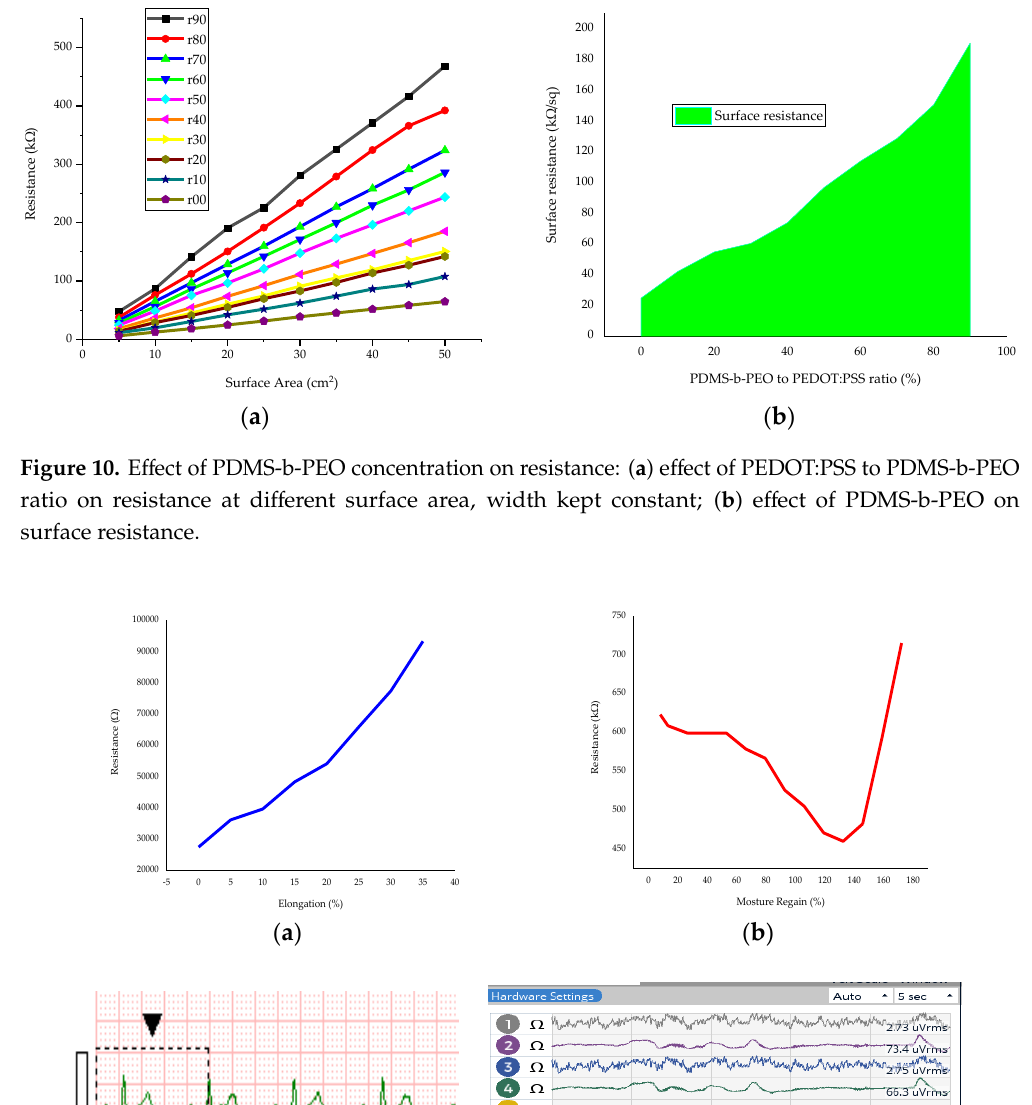
Figure 10. Effect of PDMS-b-PEO concentration on resistance: ( a ) effect of PEDOT:PSS to PDMS-b- PEO ratio on resistance at different surface area, width kept constant; ( b )effect of PDMS-b-PEO on surface resistance.